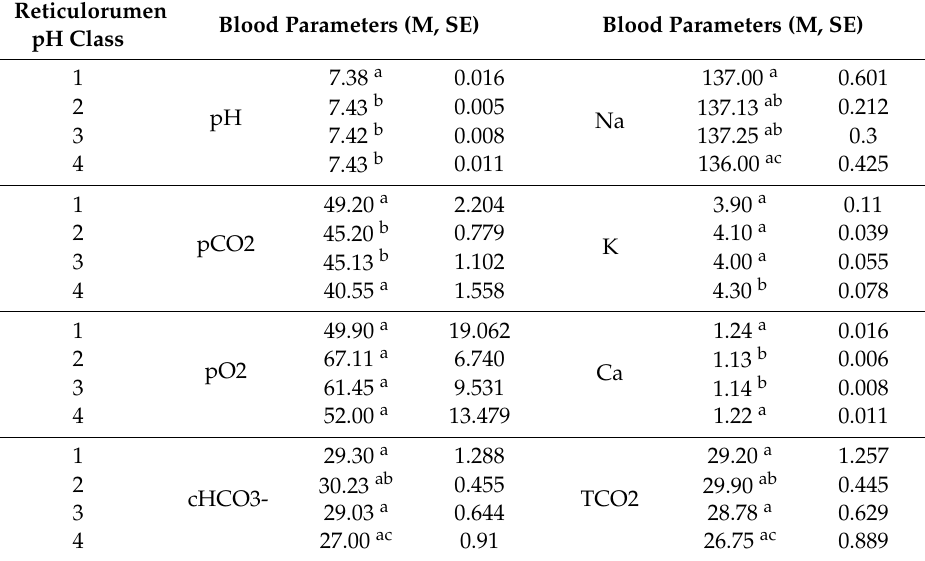
Table 3. Influence of reticulorumen pH level on blood indicators in